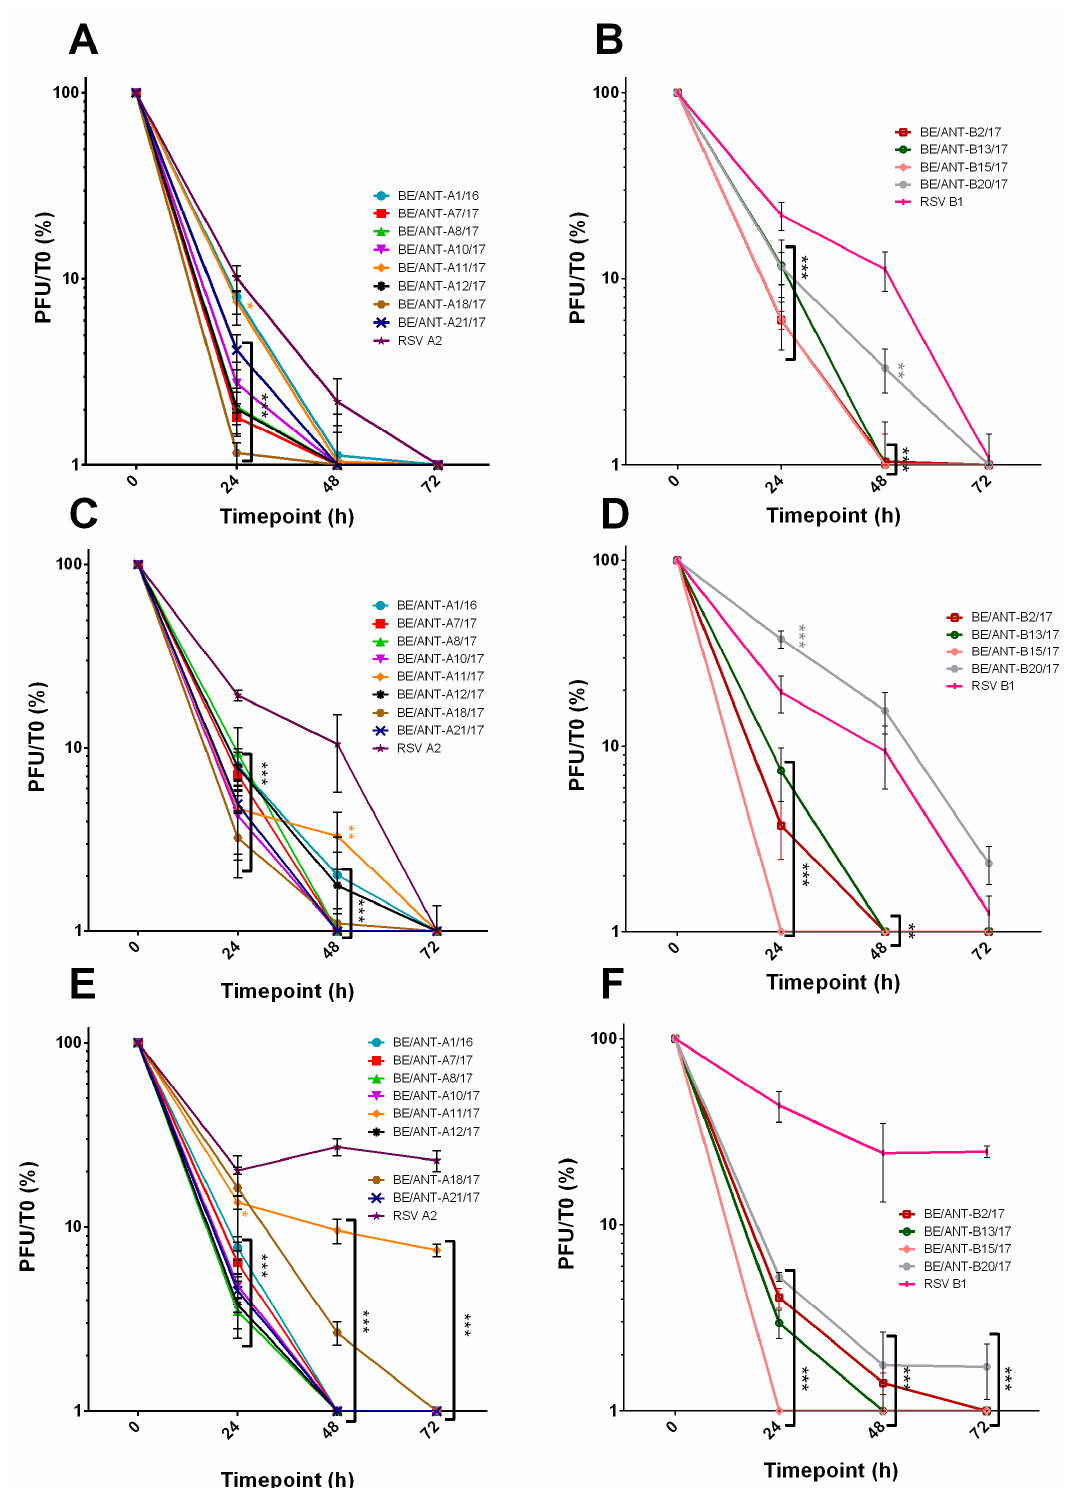
Figure 5. Thermal stability profiles at 37 °C, 32 °C and 4 °C. Clinical isolates, RSV A2 and RSV B1 were aliquoted and exposed to 37 °C ( A , B ), 32 °C ( C , D ) or 4°C ( E , F ). One aliquot of each was snap frozen at 0 h, 24 h, 48 h and 72 h. Aliquots were used for quantification by conventional plaque assay and calculated to the amount at 0 h. Data represents mean values ± SEM ( n = 3), significant differences compared to the reference strains are indicated by * p < 0.05;** p < 0.01; *** p < 0.001 (two-way ANOVA).